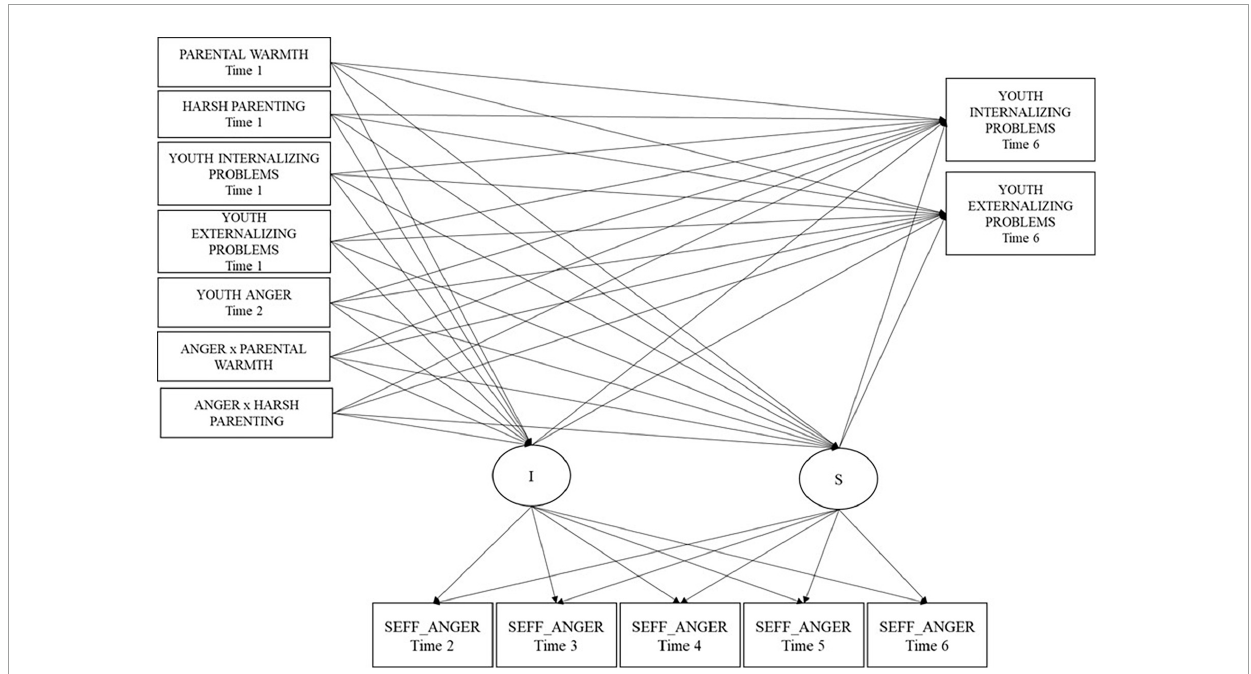
FIGURE1 Conditional multi-group latent growth curve model 1 for self-efficacy about anger regulation for the two cultural groups. We also estimated the correlations within the time among predictors and outcomes and the effect of covariates (youths’ gender and parents’ educational level. SEFF_Anger refers to self-efficacy in anger